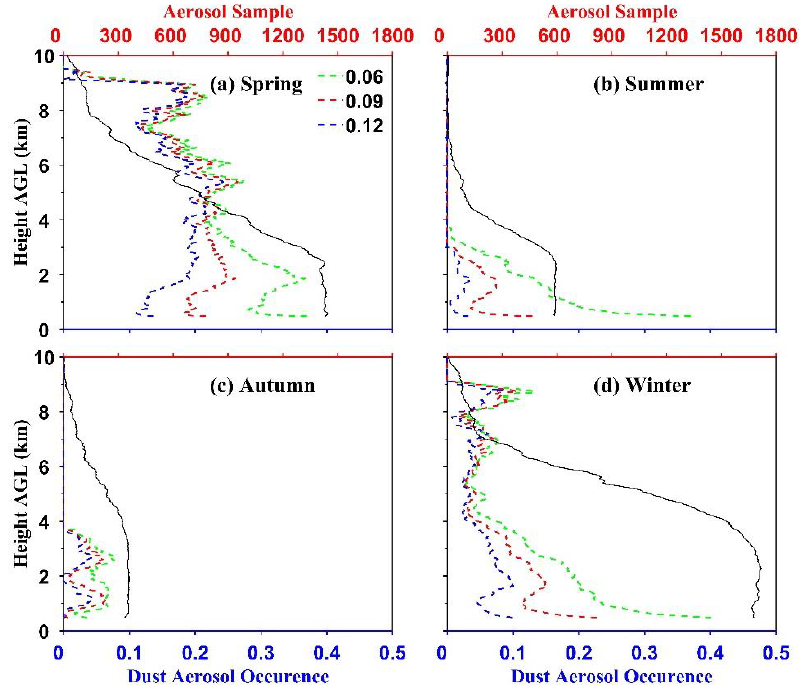
Figure 6. The aerosol samples (black line) in ( a ) spring, ( b ) summer, ( c ) autumn and ( d ) winter, and dust aerosol occurrences using the PDR thresholds of 0.06 (green line), 0.09 (red line) and 0.12 (blue line) for MPL measurements at the NSA site from January 2013 to September 2017. The samples are based on the data with 1 h and 30 m bin.